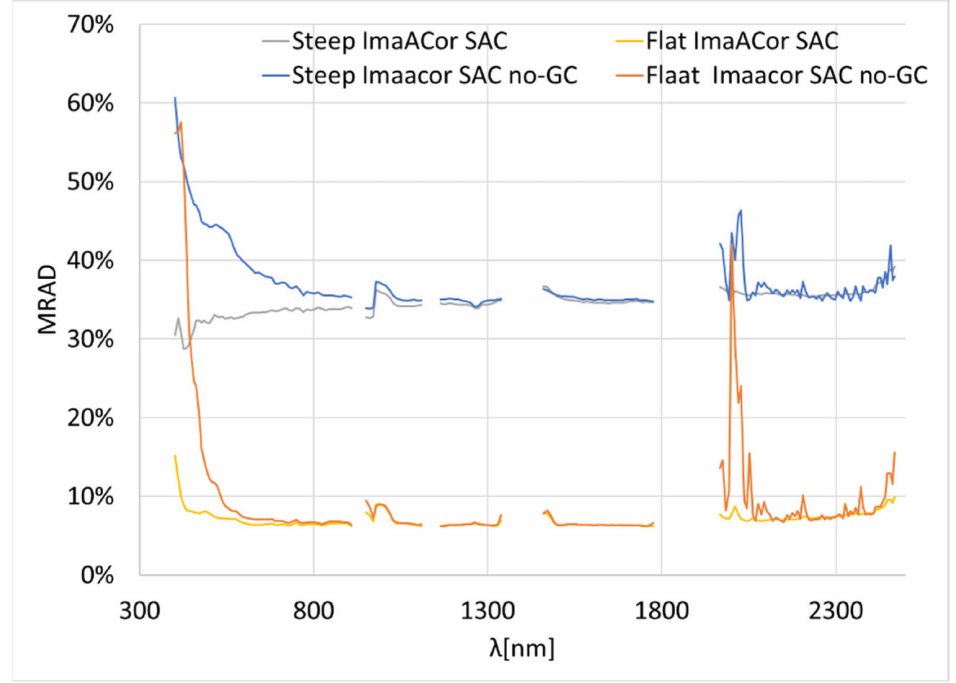
Figure 3. MRAD plots, as a function of wavelength, of ImaACor reflectances obtained from L1C PRISMA data through a SAC procedure applied both including and excluding ground compensation.